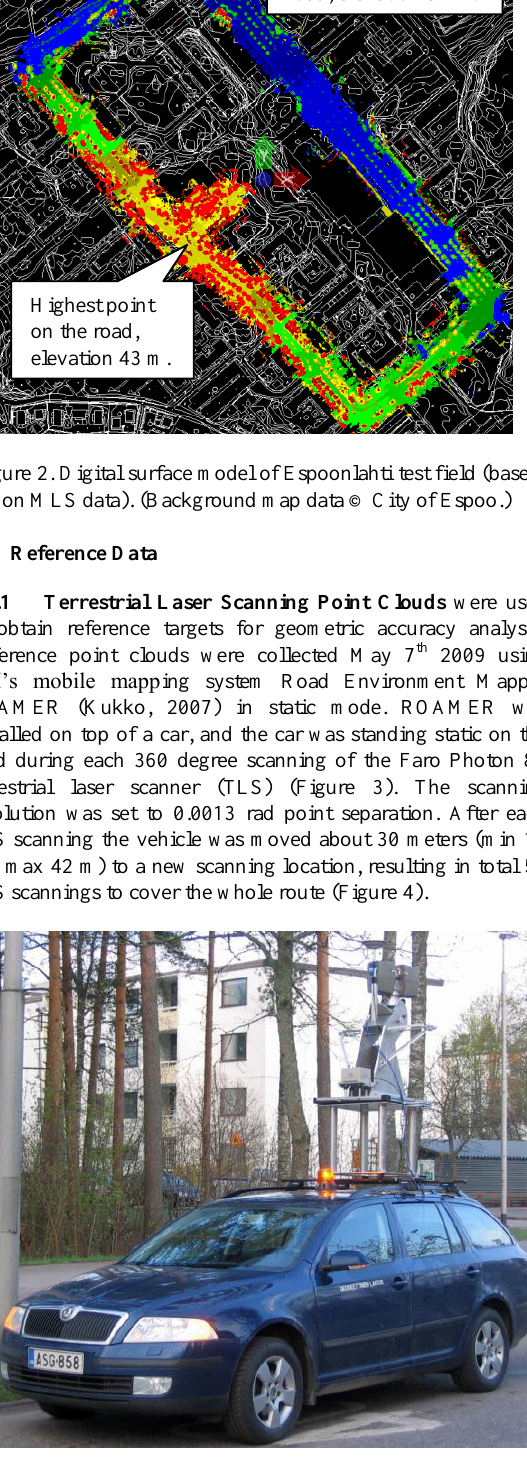
Figure 3. ROAMER in Espoonlahti test